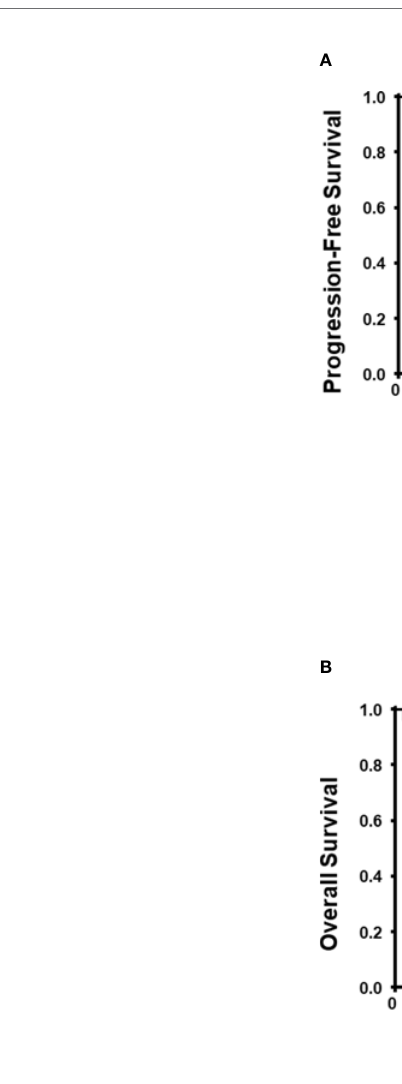
TABLE 3 | Multivariate analyses according to baseline clinical factors and therapy. No. of risk factors=3 vs.